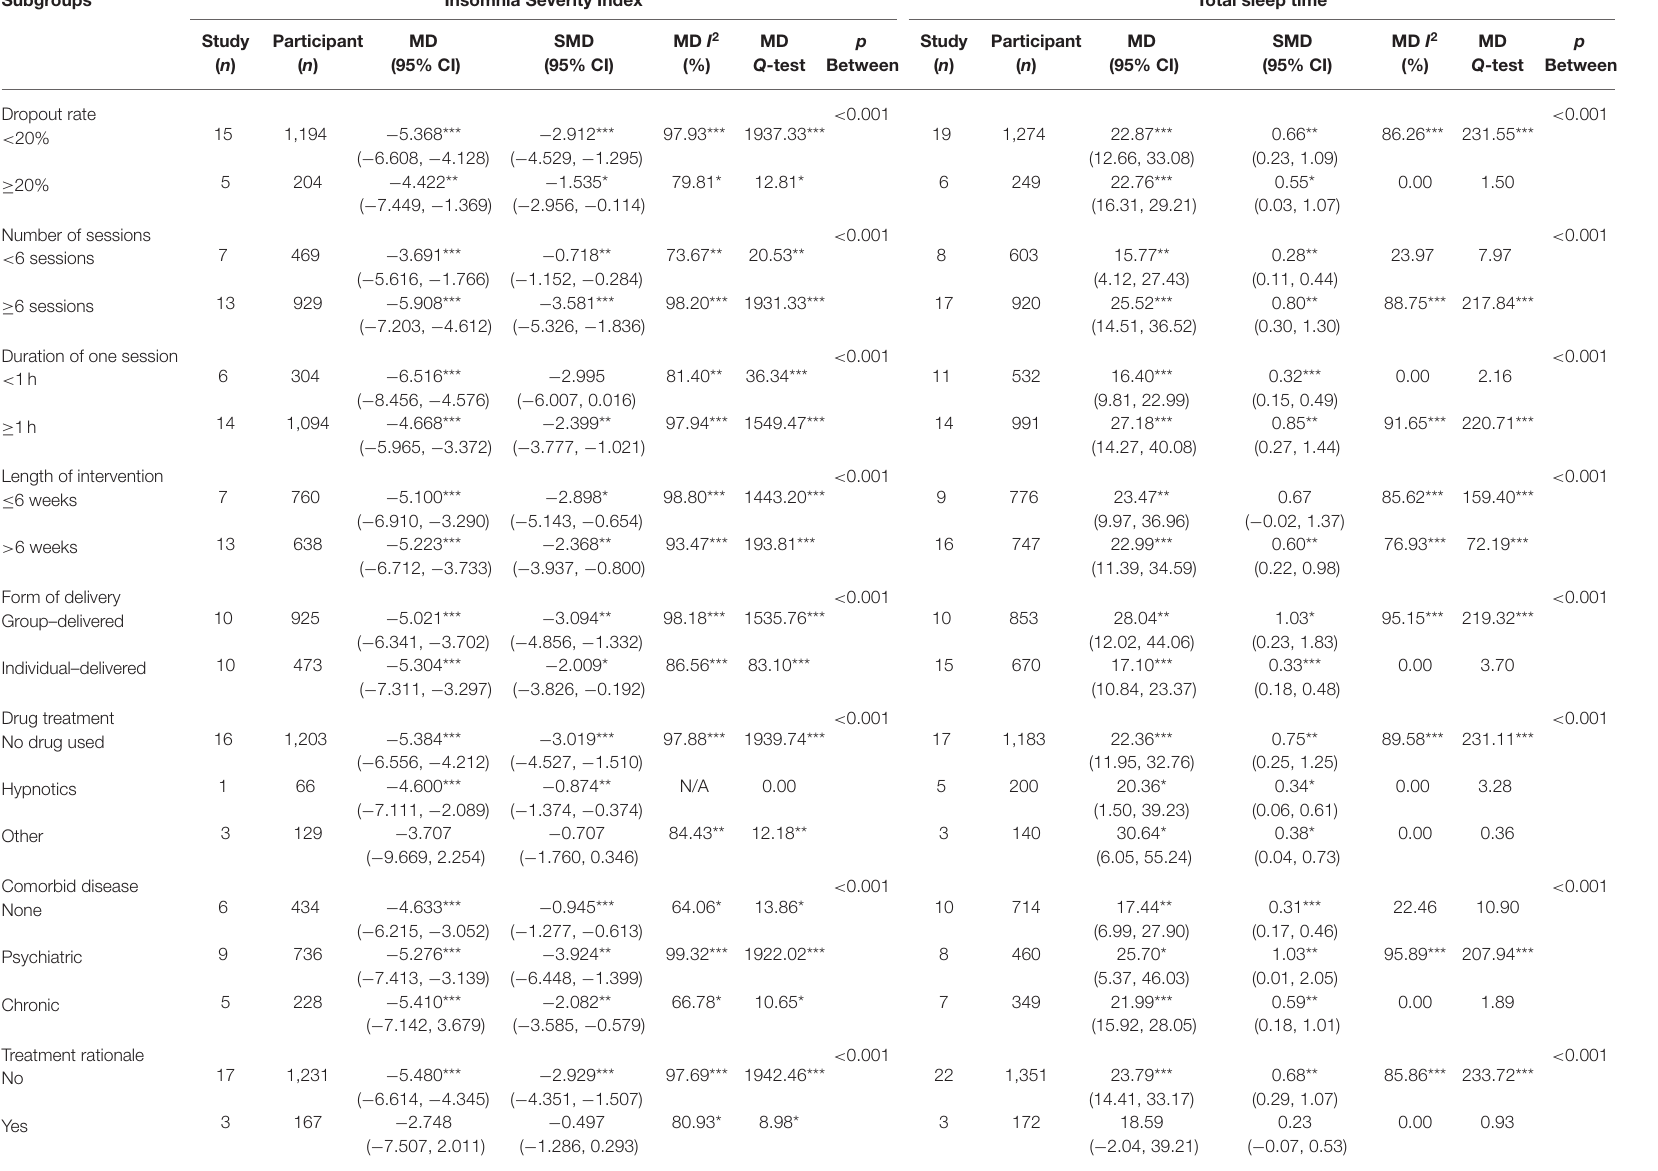
TABLE 3 | Subgroup analysis for Insomnia Severity Index and total sleep